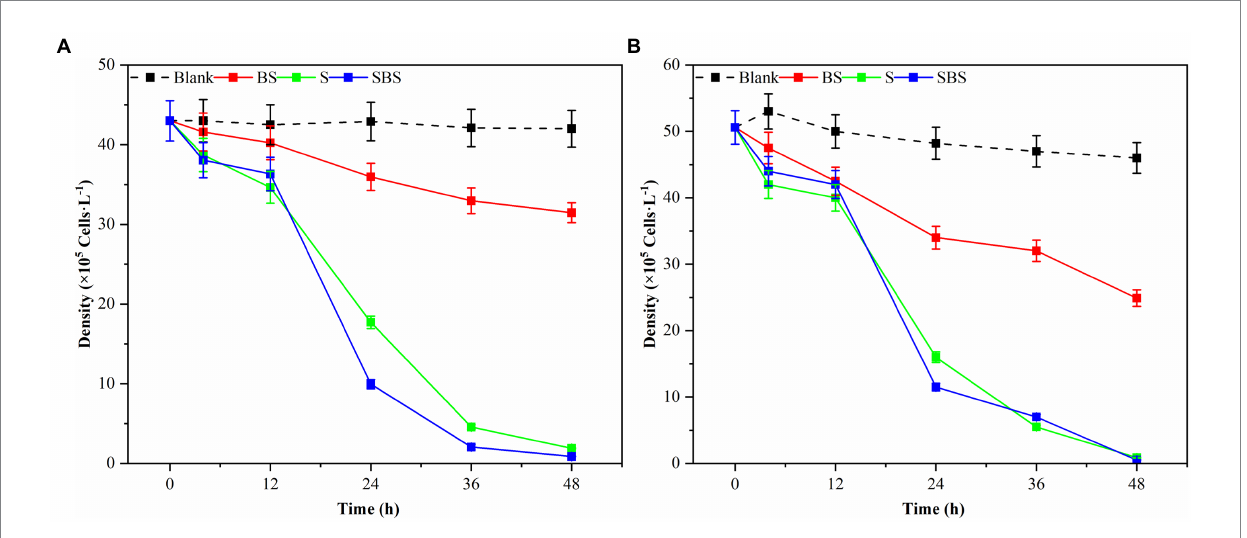
FIGURE 3 Trend of the number of different compositions of Ps3 on G. catenatum (A) and K. mikimotoi (B) [Ps3 broth (SBS); bacterial suspension (BS); Pseudomonas Ps3